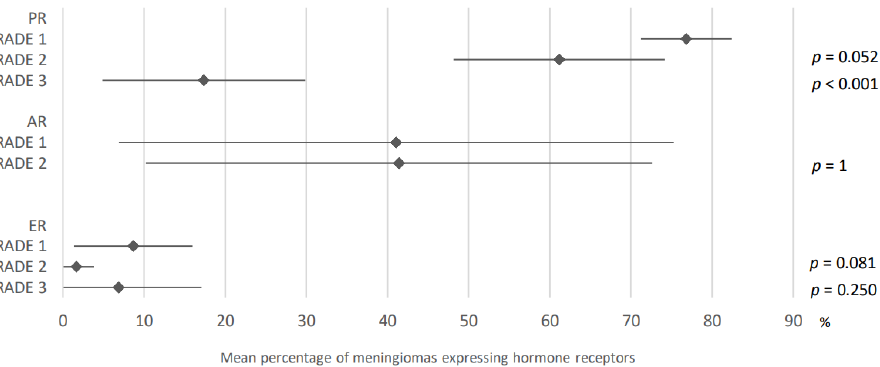
Figure 11. Comparison of hormone receptors expression in meningiomas according to grade. PR: progesterone receptors; AR: androgen receptors; ER: estrogen receptors. The results are expressed as a mean associated with their 95% confidence interval. p : grade 1 versus grade 2 or 3. Number